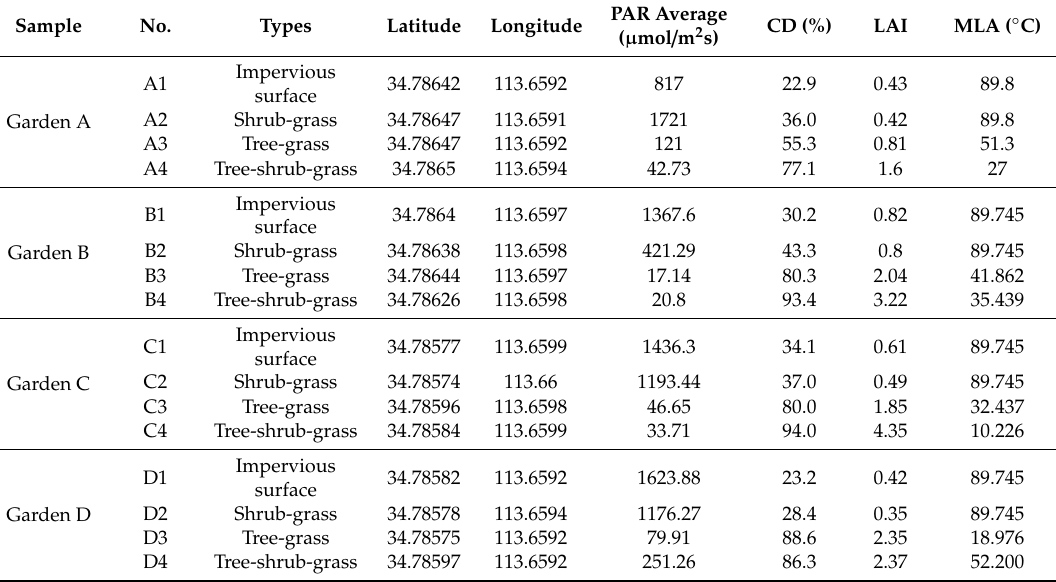
Table 1. The statistics of each